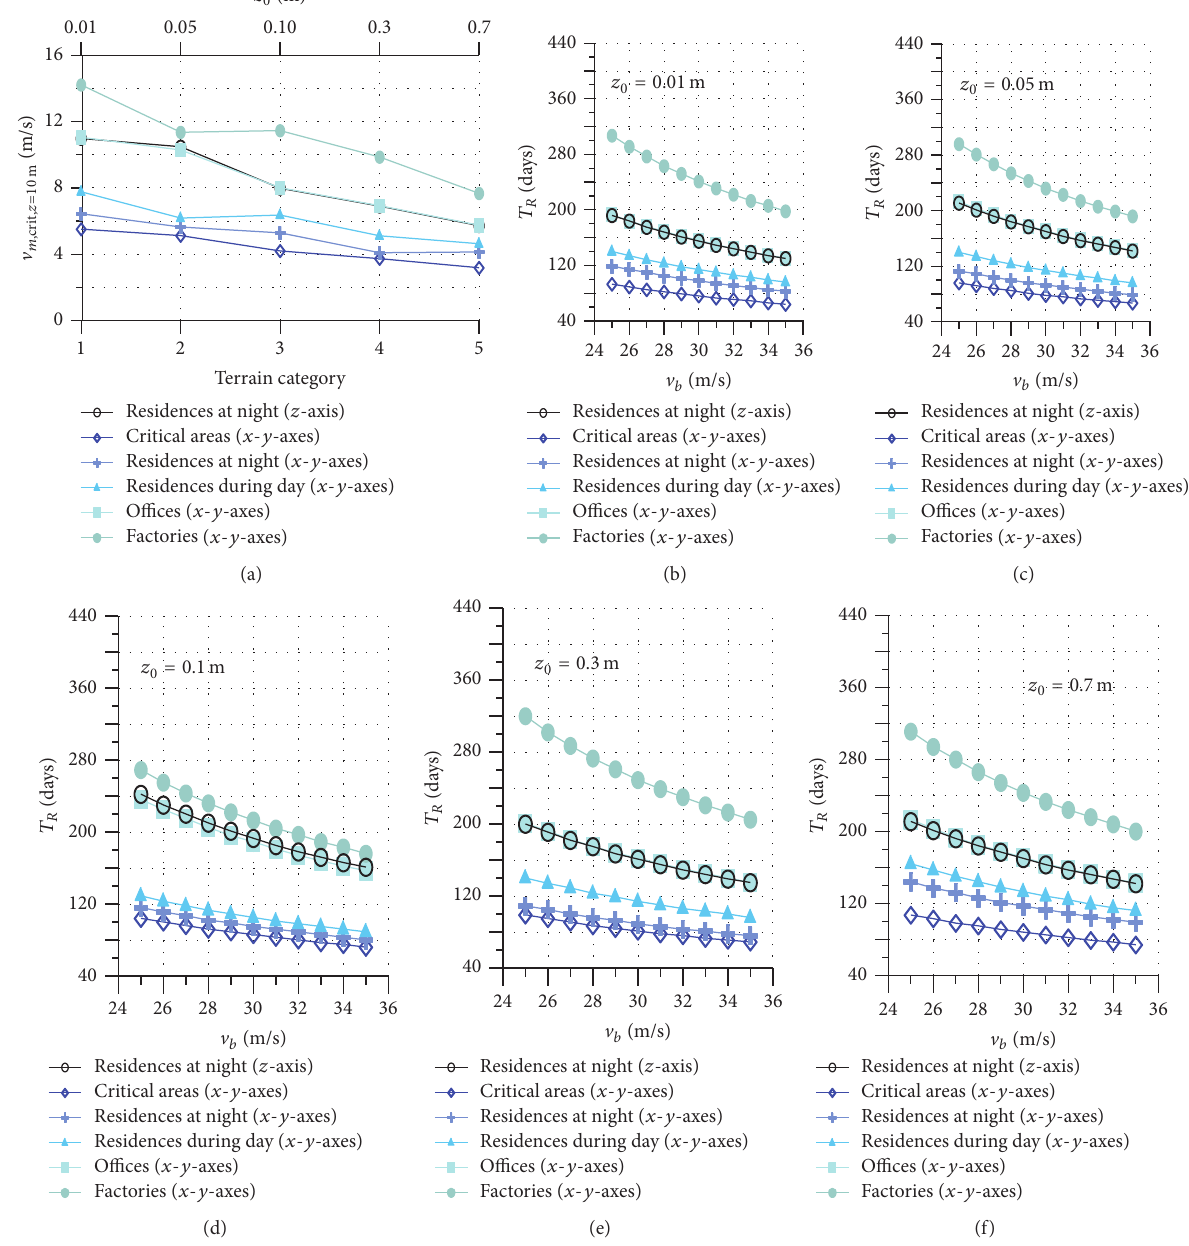
Figure 6: Critical 10-minute mean wind velocity at a height of 10 m determining discomfort as a function of the terrain category (or roughness length, 𝑧 0